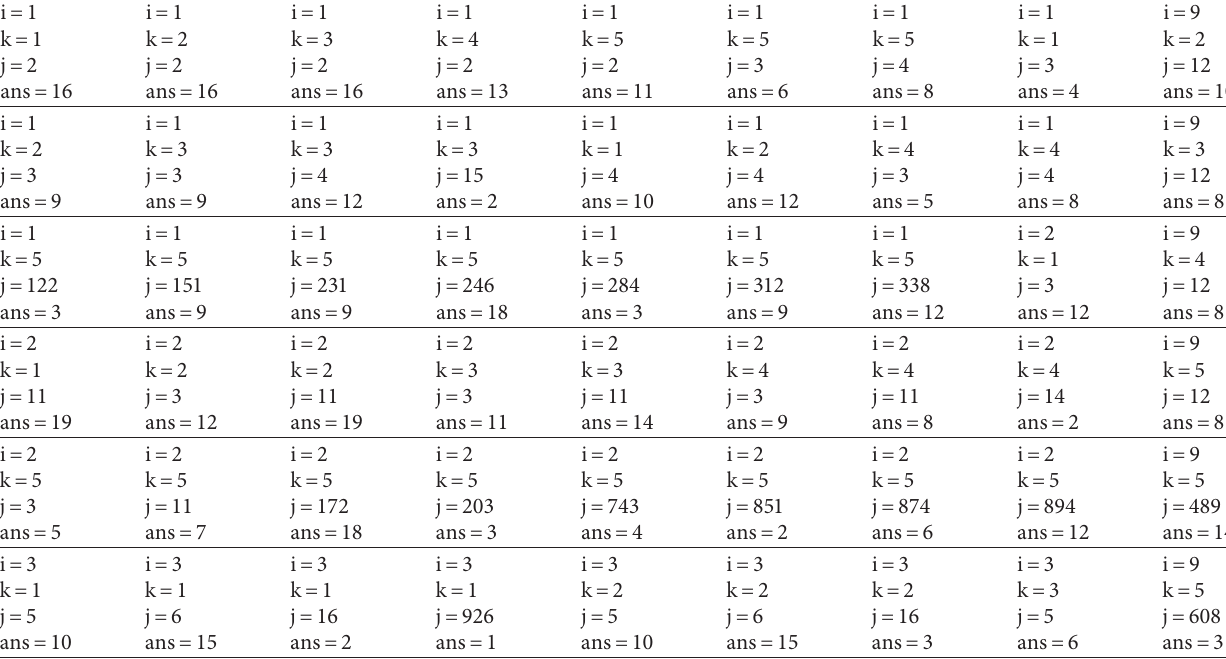
Table 14: Optimization results for